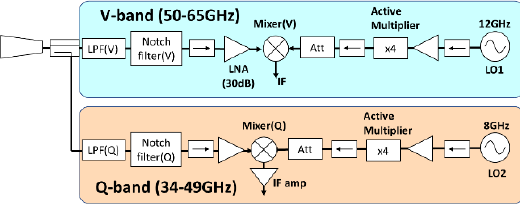
Fig. 6. System schematic of heterodyne radiometer RF section. LPF, LNA, and Att represent a low-pass filter, a low-noise amplifier, and an attenuator, respectively. The LO frequencies of the mixer are 48 GHz and 32 GHz for V-band and Q-band,